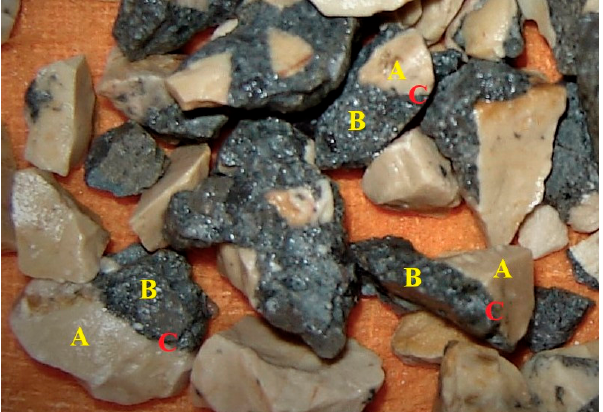
Figure 1. RA constitution. ( A ) Coarse NA; ( B ) Adhered mortar; ( C ) Interface between coarse NA and adhered mortar.